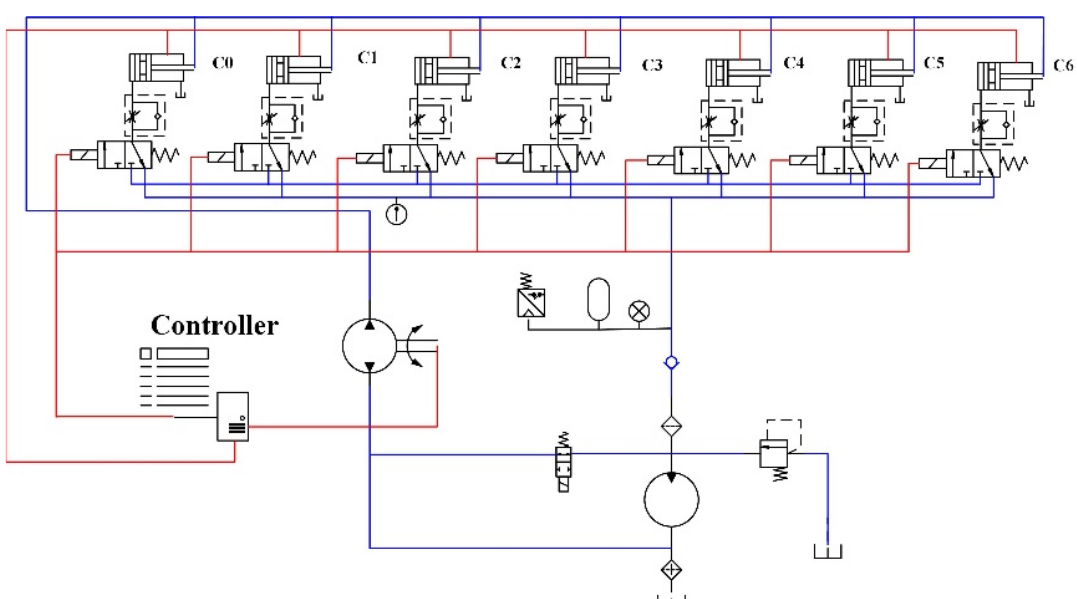
Figure 4. HMCVT simulation system diagram.